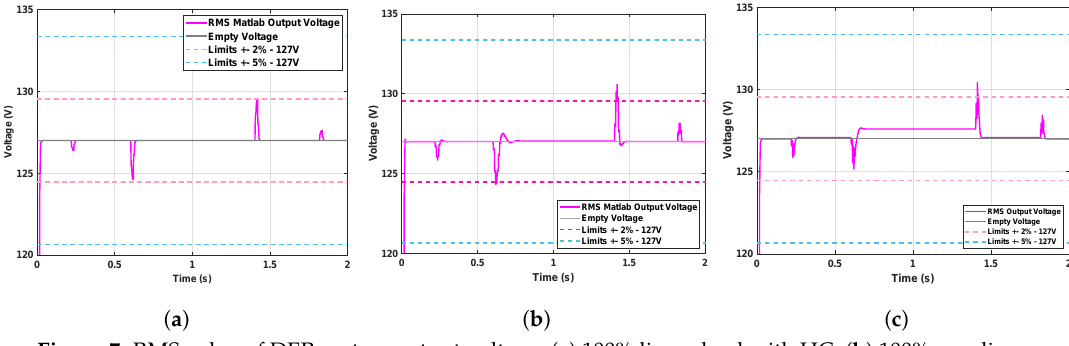
Figure 7. RMS value of DER system output voltage. ( a ) 100% linear load with HC. ( b ) 100% non-linear load with HC. ( c ) 100% non-linear load without HC.